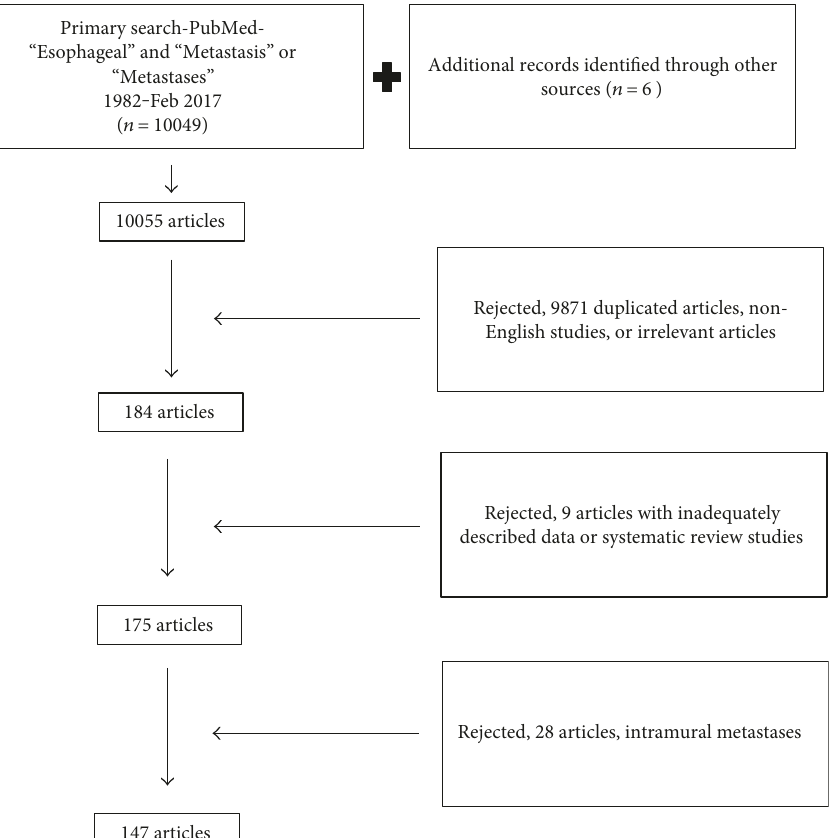
Figure 1: The selection process of the